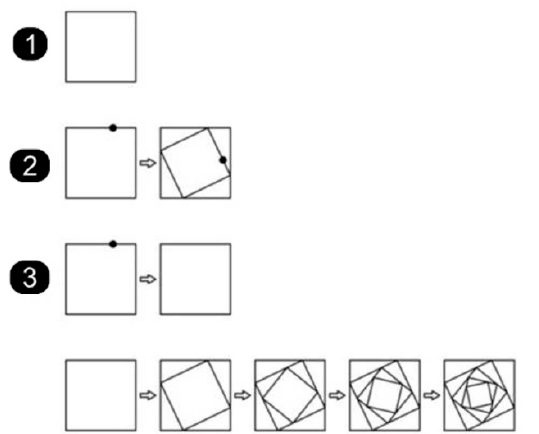
Figure 10. Standard shape grammar—initial shape ( 1 ), transformation rule ( 2 ), termination rule ( 3 ), and results generated by applying the transformation rules recursively [32] .